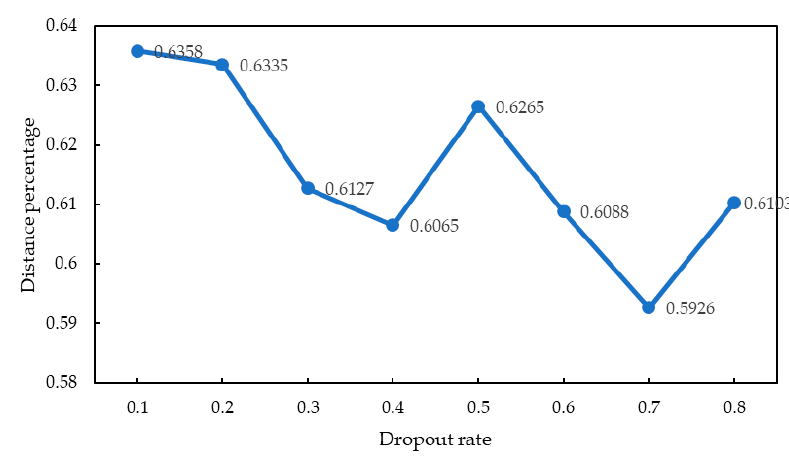
Figure 13. The distance percentage of different dropout rates.